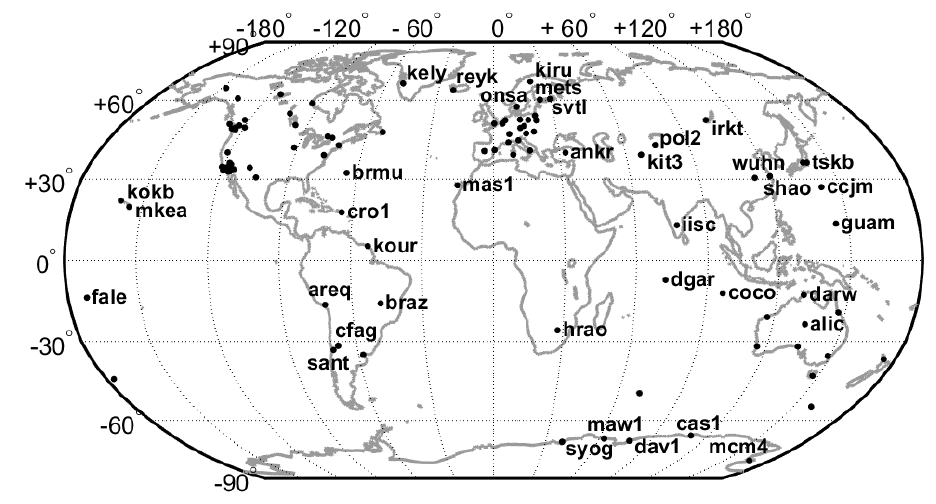
Figure 1. Map showing the 104 GPS stations used in this study. The stations discussed in the text and the Appendix are identified by their four-character